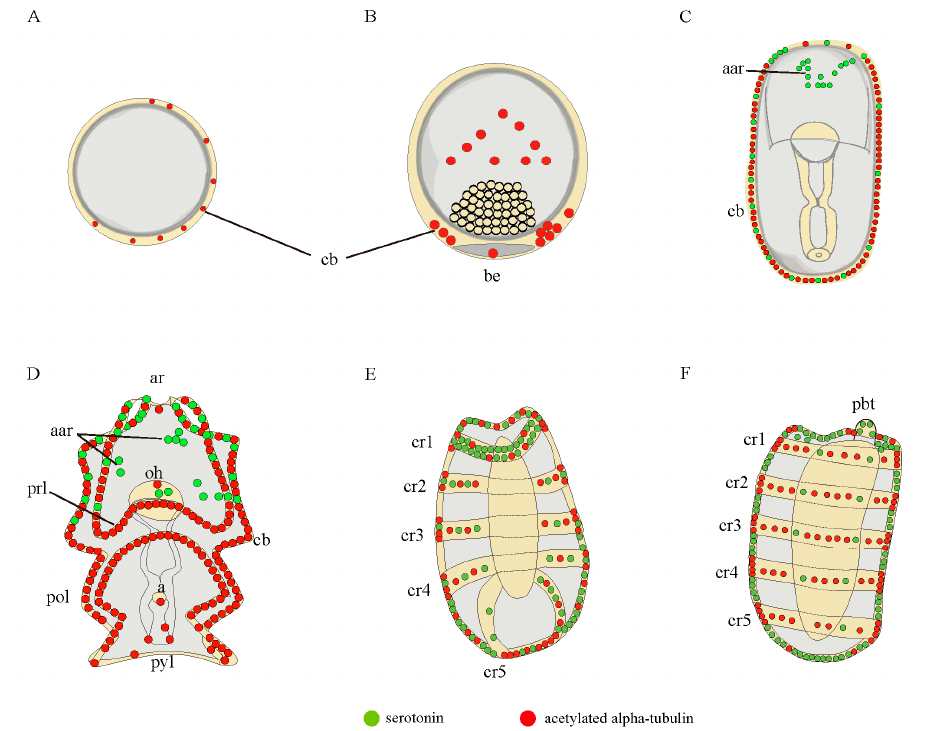
Figure 3. A diagrammatic representation of the nervous system of A. japonicus embryos and larvae stained by serotonin (green) and acetylated α -tubulin (red). ( A ) blastula; ( B ) gastrula; ( C ) late gastrula; ( D ) auricularia; ( E ) doliolaria; ( F ) pentactula. The labels are: a, anus; aar, anterior apical region; ar, apical ridge; be, blastopore; cb, ciliary band; cr, ciliary ring; oh, oral hood; pbt, primary buccal tentacle; pol, posterior loop; prl, preoral loop; pyl,